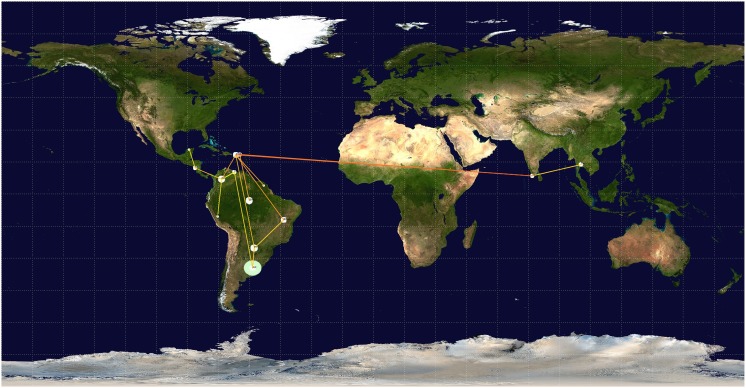
Inferred spread obtained by a discrete phylogeographic analysis of DENV-1 genotype V.The KML file for visualization in Google Earth is available as a supplementary dataset (Video S1).